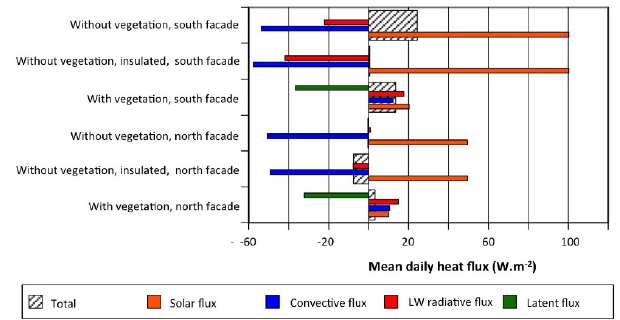
Figure 13. Mean daily heat fluxes on the external walls of the third floor, on 26 June 2010. Averaged over the day, the thermal fluxes transmitted through the wall and stored in it are reduced by 50% for the south ‐ facing facade due to greening. For the north ‐ facing facade, the effect is reversed: without vegetation, the thermal balance is negative, i.e. , this facade contributes to cooling the building, but with vegetation, it is slightly positive. This finding is consistent with previously ‐ observed trends: the large decrease in incoming solar flux and evaporation flux limits the contribution of the surface to the heating of indoor air.